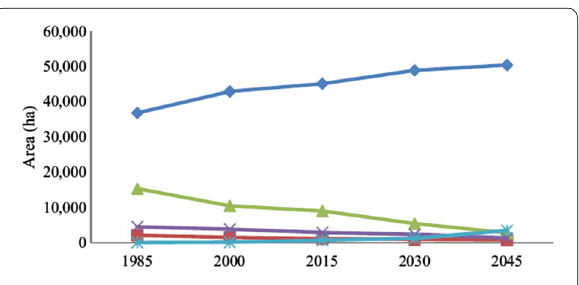
Shrubland Grassland